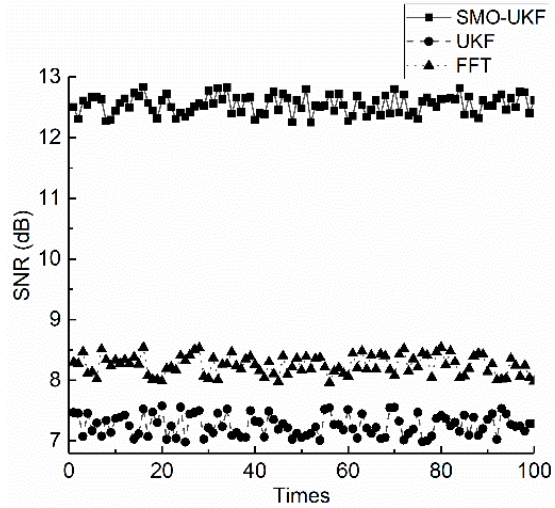
Figure 9. Denoising stability test with different filtering methods.